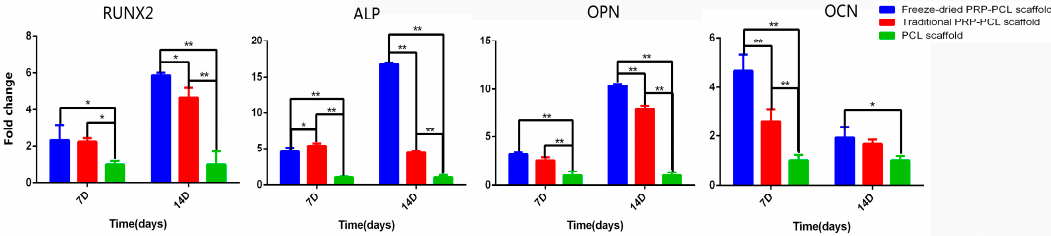
Figure 7. Expression of bone-specific genes, RUNX2, ALP, OPN, and OCN on the freeze-dried PRP-PCL scaffold, traditional PRP-PCL scaffold and bare PCL scaffold (* p < 0.05, ** p < 0.01).